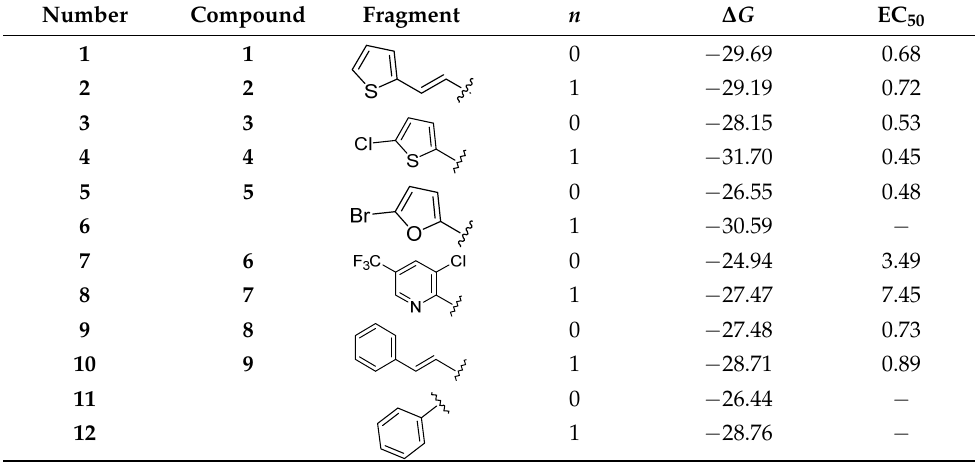
Table 4. The six screened fragments.